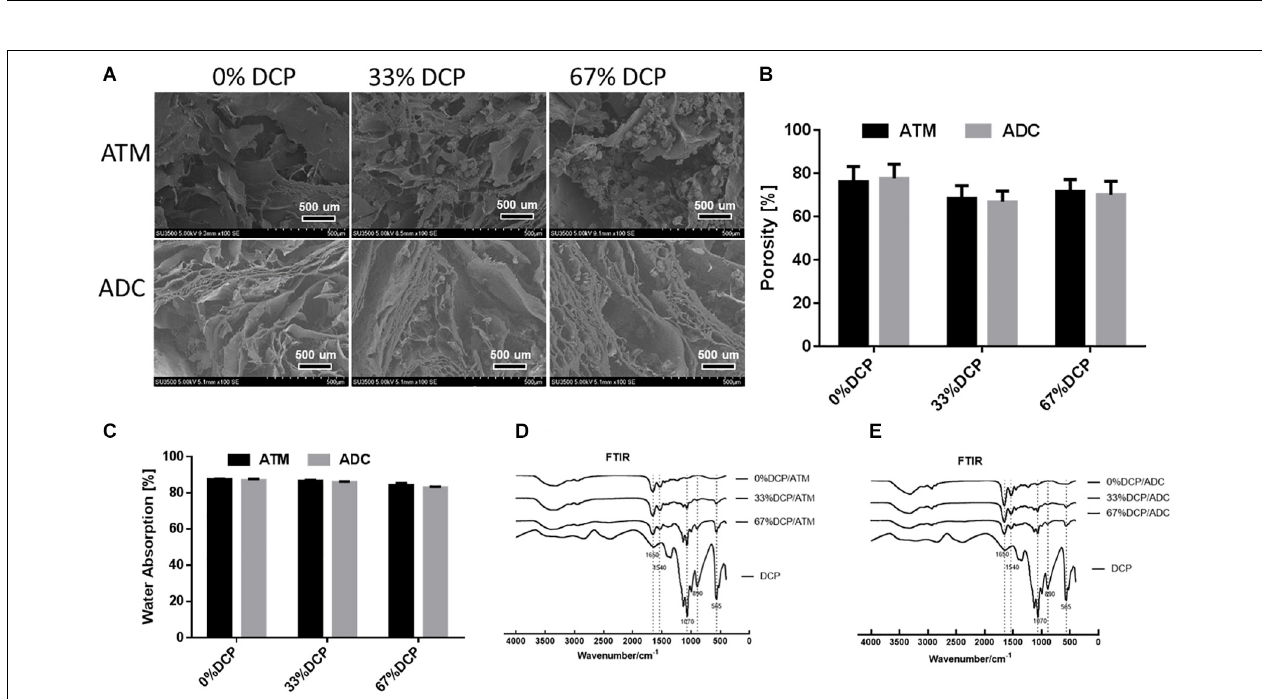
FIGURE 3 | Physicochemical characterization of DCP/ATM composite scaffold: (A) the upper row shows SEM of ATM group with varying DCP contents; the lower row shows SEM of ADC group with varying DCP contents. (B) Porosity of DCP/ATM and DCP/ADC composite scaffolds with various DCP contents. (C) Water absorbance rate of DCP/ATM and DCP/ADC composite scaffolds with various DCP contents. (D) FTIR spectrum of DCP/ADC scaffolds with various DCP contents. (E) FTIR spectrum of DCP/ADC scaffolds with various DCP contents.